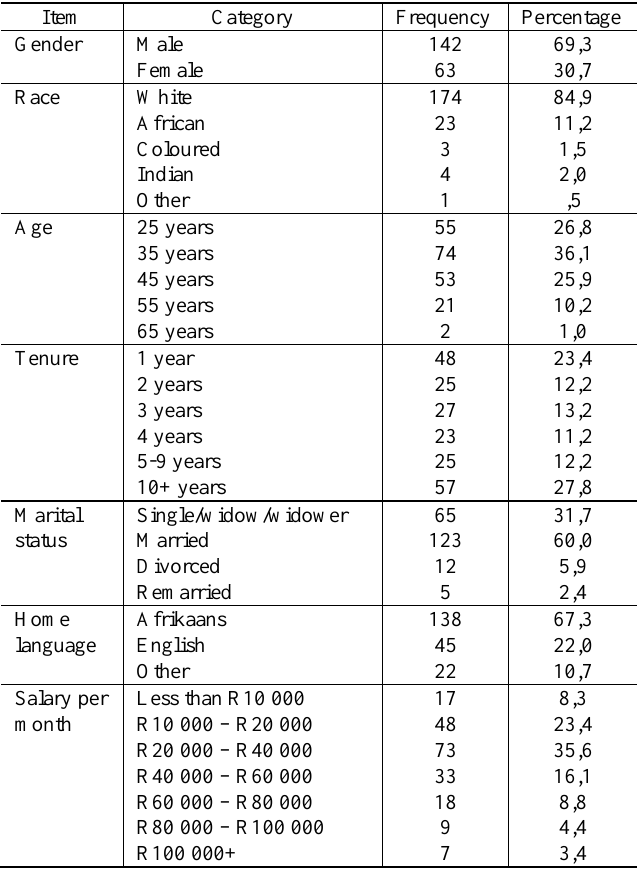
Table 2: Characteristics of the participants ( N =205)